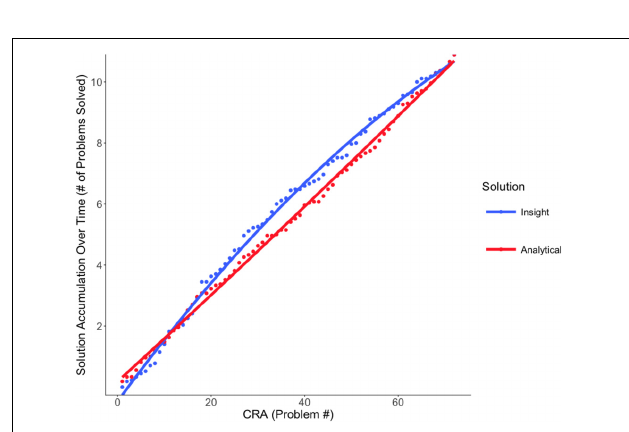
FIGURE 2 | Solution difference score by priming type. Model fit of the solution difference score (insight solutions – analytical solutions) by priming type (near-future versus far-future) over the series of CRA problems.